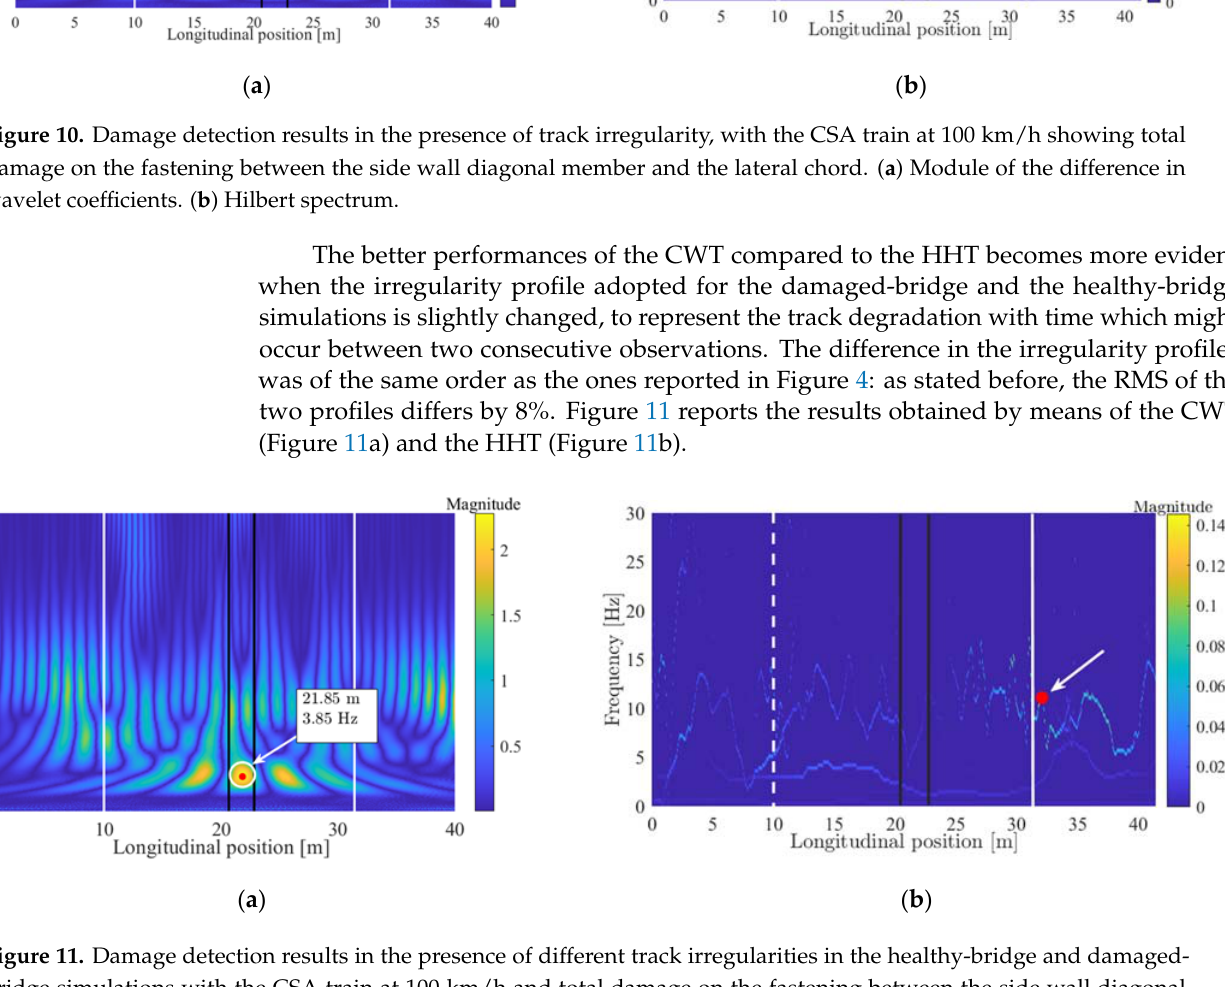
Figure 10. Damage detection results in the presence of track irregularity, with the CSA train at 100 km/h showing total damage on the fastening between the side wall diagonal member and the lateral chord. ( a ) Module of the difference in wavelet coefficients. ( b ) Hilbert spectrum.